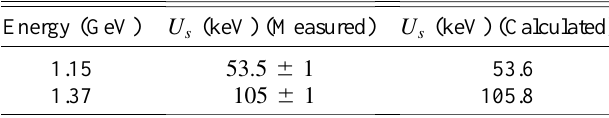
TABLE I. Main LNLS storage ring parameters. Nominal energy